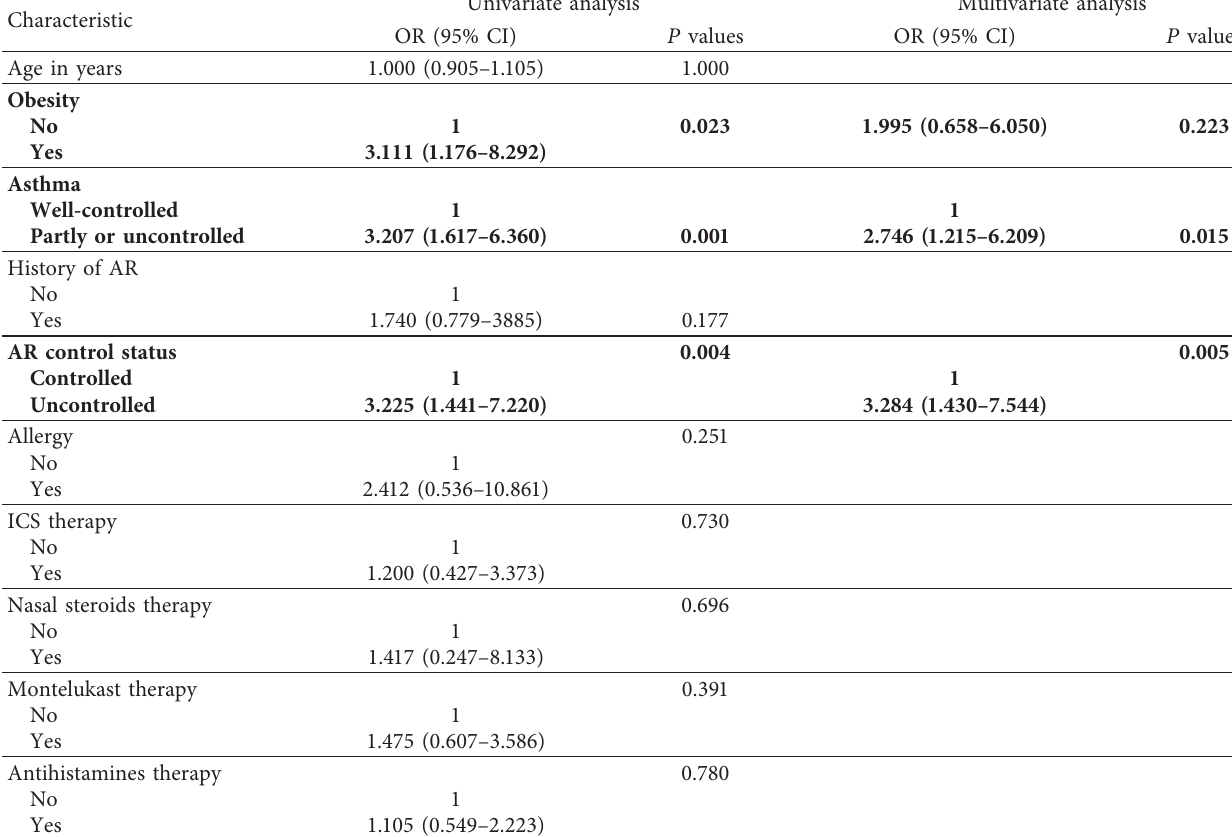
Table 3: Risk factors for SRBD in asthmatic